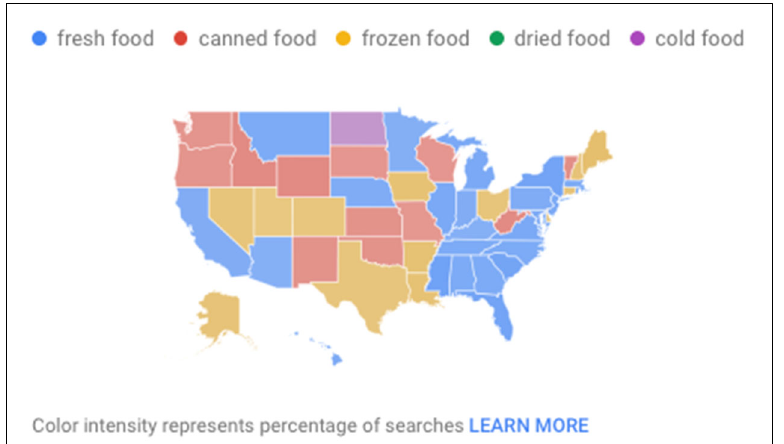
Figure 1a. Distribution of Prominent Search Terms by State